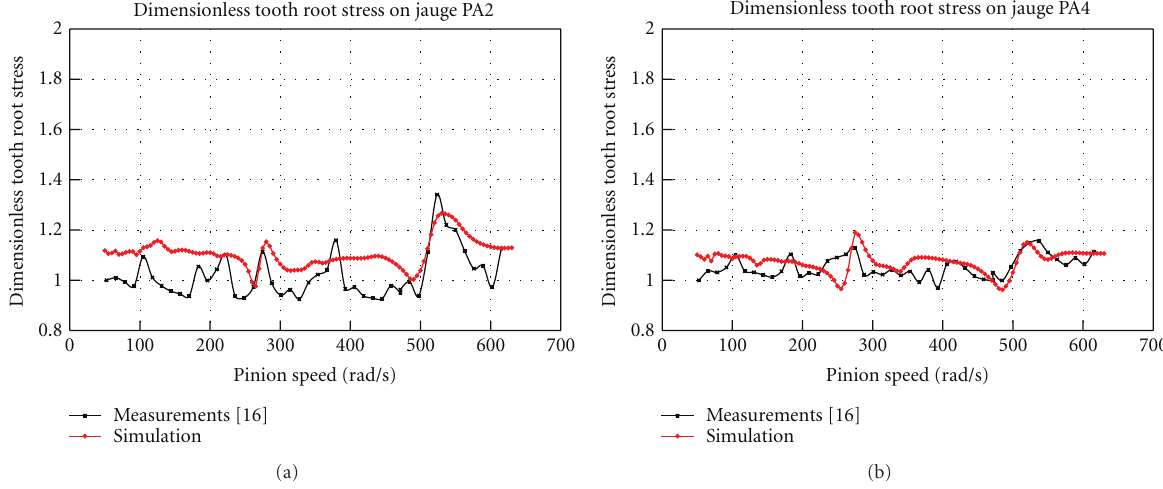
Figure 6: Comparisons between the simulated and measured dimensionless tooth root stress (helical gear case), with C r = 1540N · m and maximum bearing spacing, (a) on gauge PA2, (b) on gauge